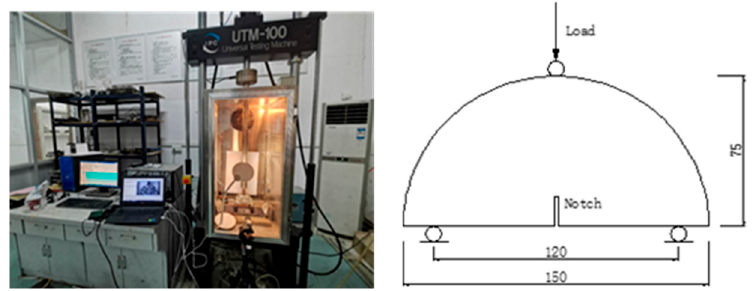
Figure 4. The SCB test loading system and the force